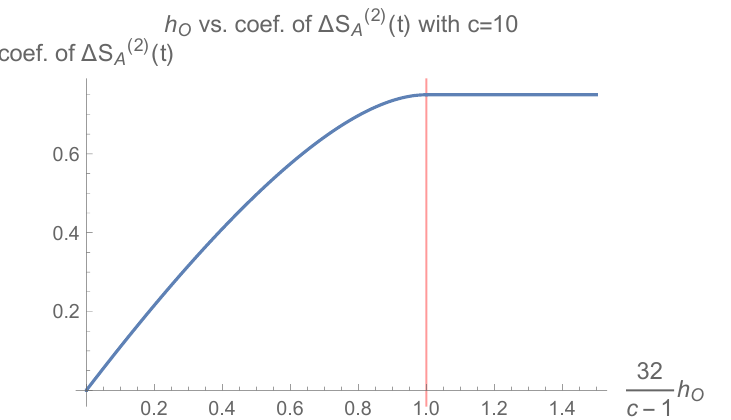
Figure 9 . The h O dependence of the coe(cid:14)cient of the growth of the 2nd Renyi entropy after a local quench. This dependence might imply that in a CFT with c > 1 and no extra currents, the heavier the operator used to create a local quench, the larger is the entropy growth; however, if its dimension exceeds the value c (cid:0) 1 , then the entropy is saturated by 32